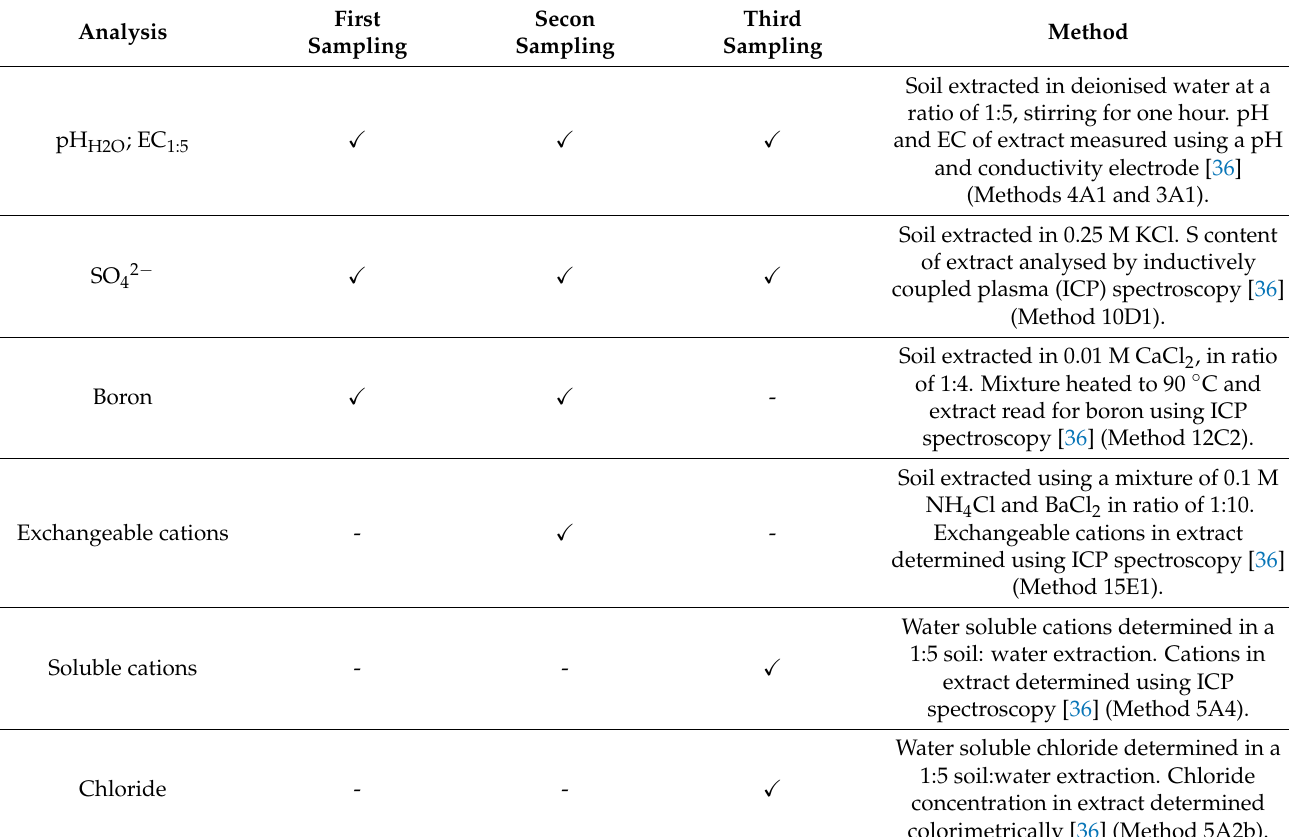
Table 1. Soil data collected at the three times of